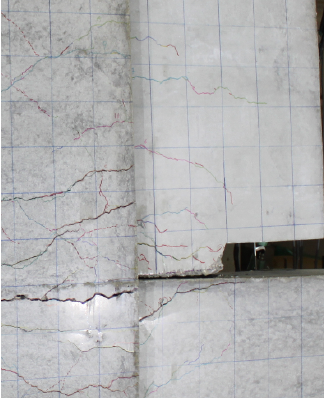
Figure 10. Dominant large crack.